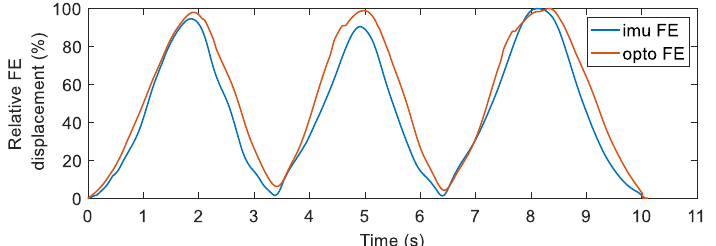
Figure 10. Relative flexion and extension displacement (FE) of the knee during the passive flexion and extension test calculated from measurements of the optoelectronic system ( opto ) and those of the IMUs of the smart brace ( imu ).